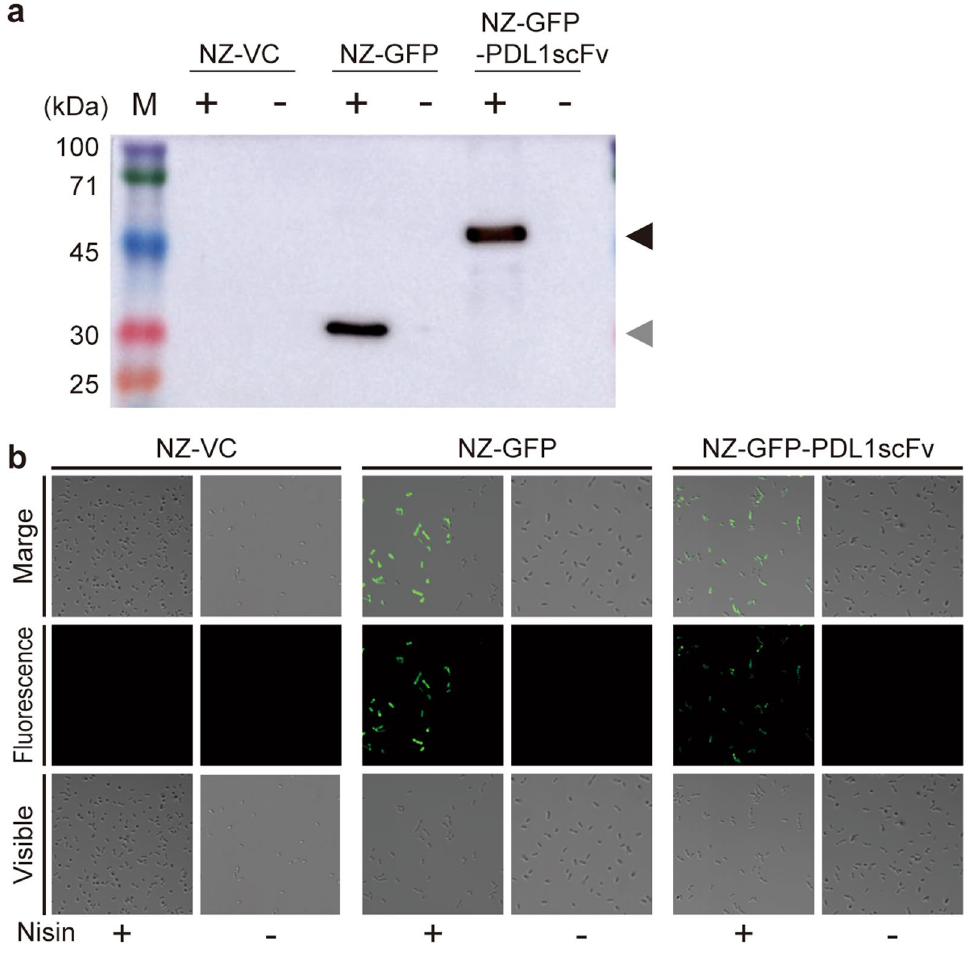
Fig. 2 Gene expression and fluorescence analysis. NZ-VC, NZ-GFP, and NZ-GFP-PDL1scFv were cultured with/without nisin, and gene expression and fluorescence were analyzed. a The cell extracts were subjected to WB using an anti-His tag antibody to detect the expression of rGFP-PDL1scFv by the gmLAB. The black arrow indicates the band corresponding to rGFP-PDL1scFv (59.0 kDa). The gray arrow indicates the band corresponding to rGFP (31.0 kDa). M: molecular mass marker (kDa). b Fluorescence analyses of gmLAB. Each gmLAB was observed by confocal laser scanning microscopy using an oil immersion objective lens ( 60) under visible and fluorescent light, and merged images were generated. × presence of nisin